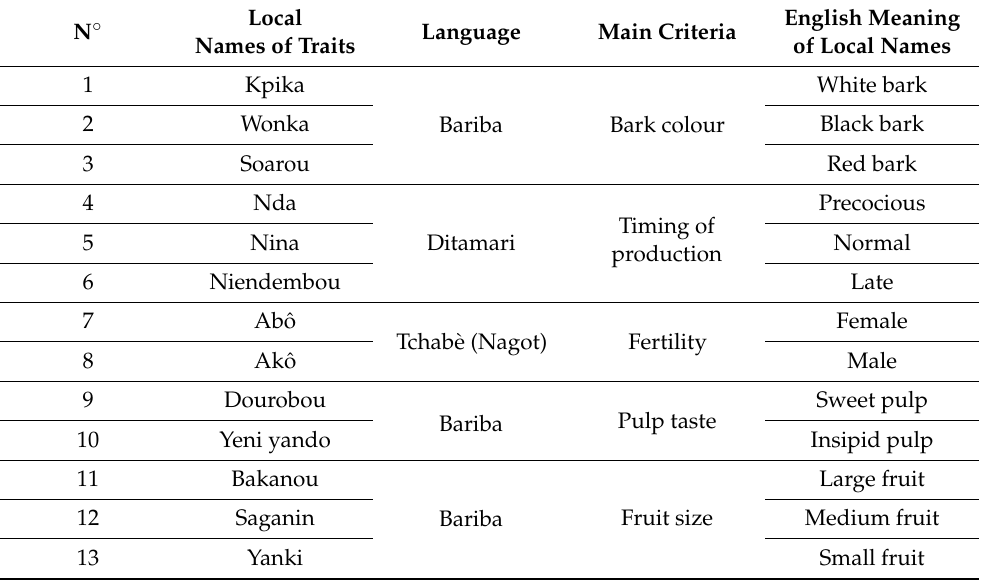
Table 2. Most-mentioned traits related to shea morphotypes in Benin.